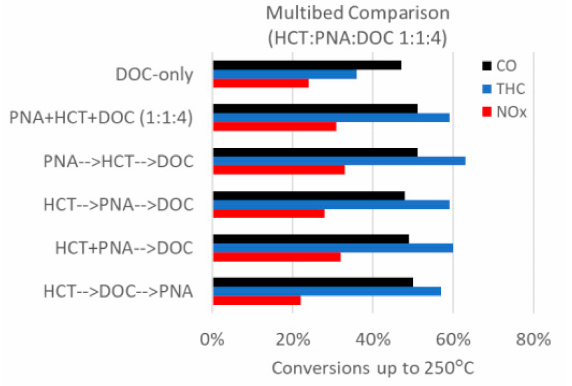
Figure 6. Overall conversions for CO, THC, and NOx in the temperature window below 250 ◦ C over several multibed reactor configurations.